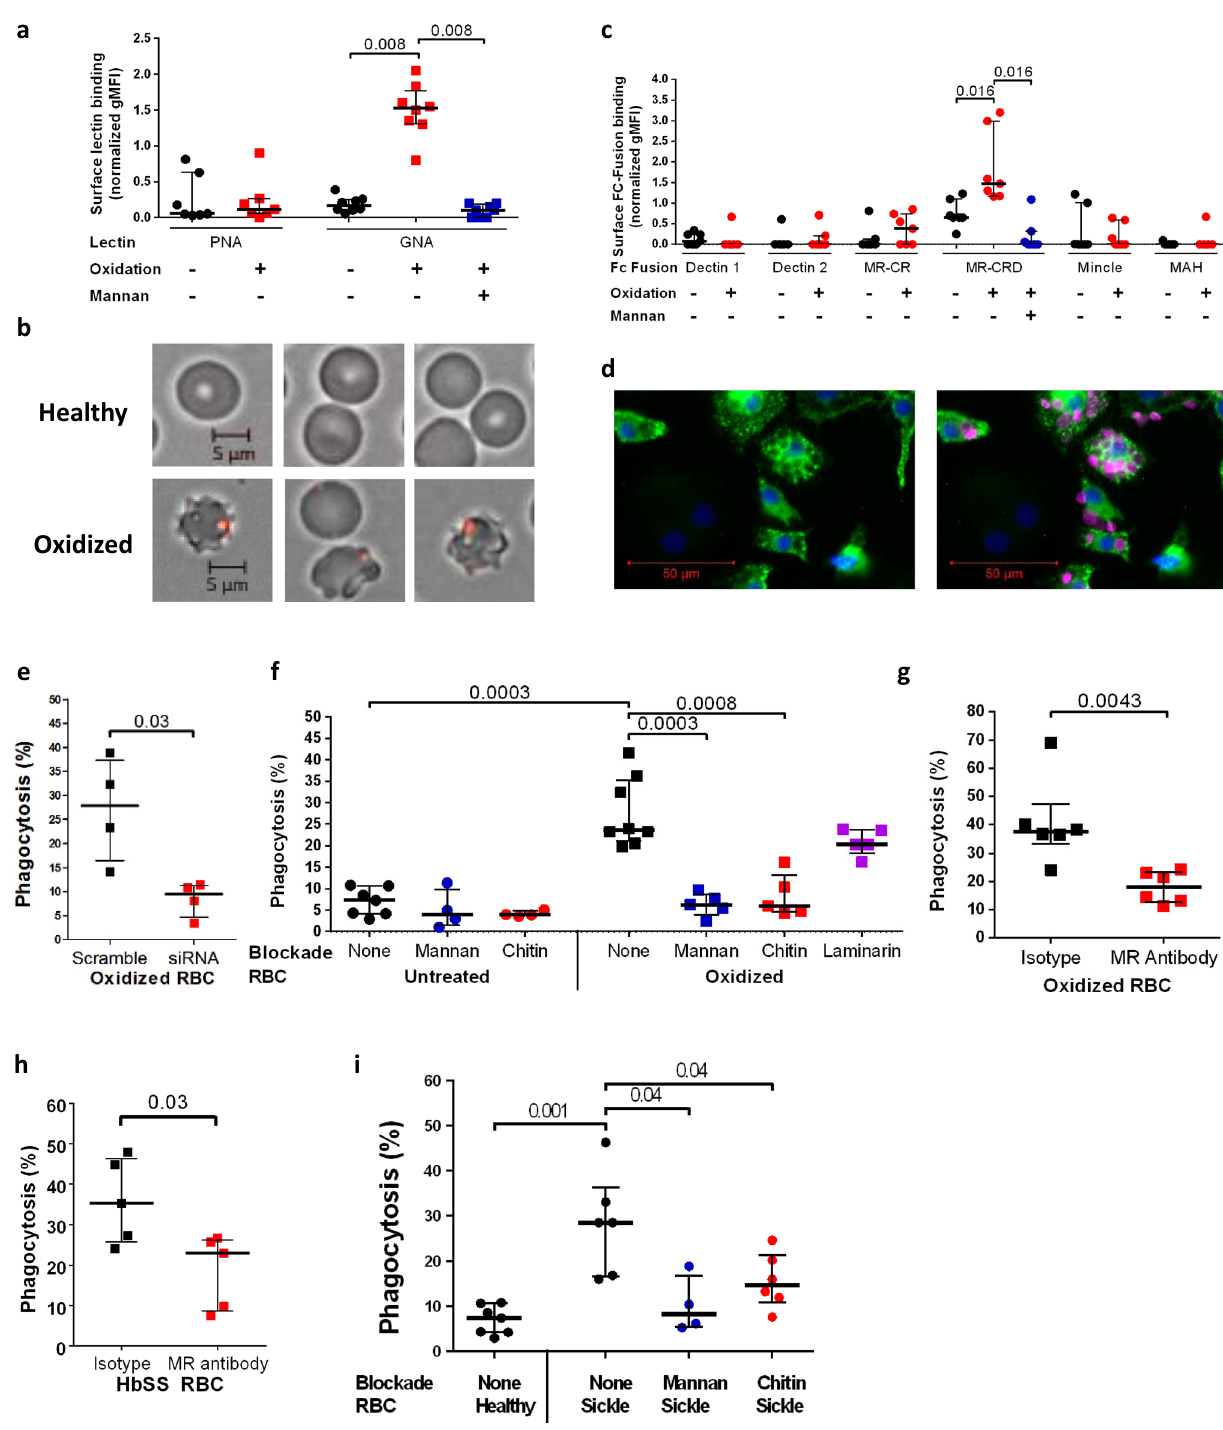
glycoproteomic analysis. Proteomic analysis of F40 identi fi